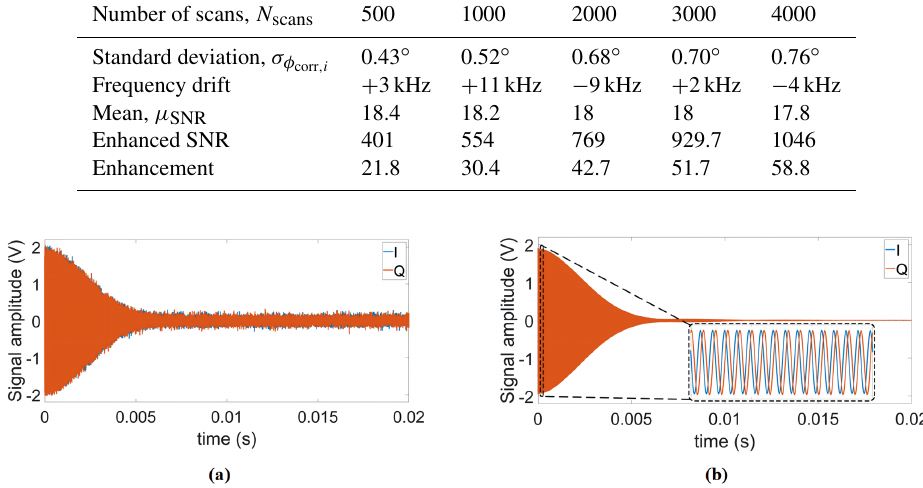
Figure 7. (a) Single scan and (b) time-averaged ( N scans = 4000) FID signals using our proposed DDS-based reference signal generator.